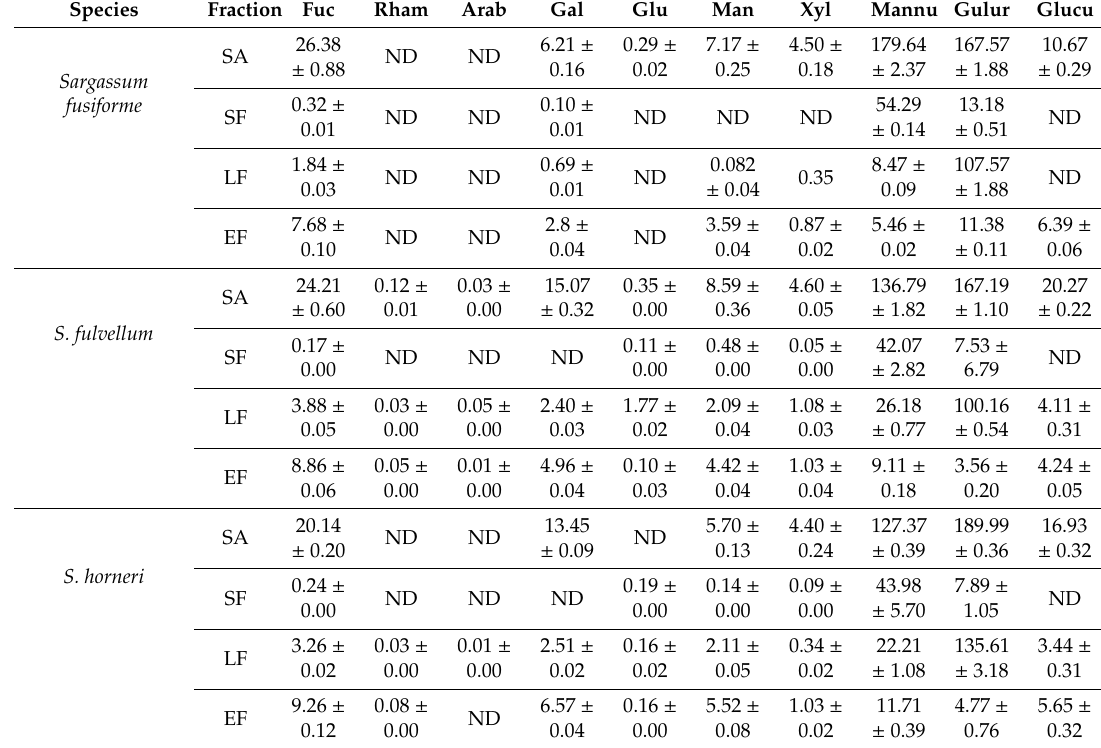
Table 3. Monomeric carbohydrate contents from Sargassum species determined by high-performance anion-exchange chromatography with a pulsed amperometric detector (HPAEC-PAD) analysis after two-step sulfuric acid hydrolysis (mg · g − 1